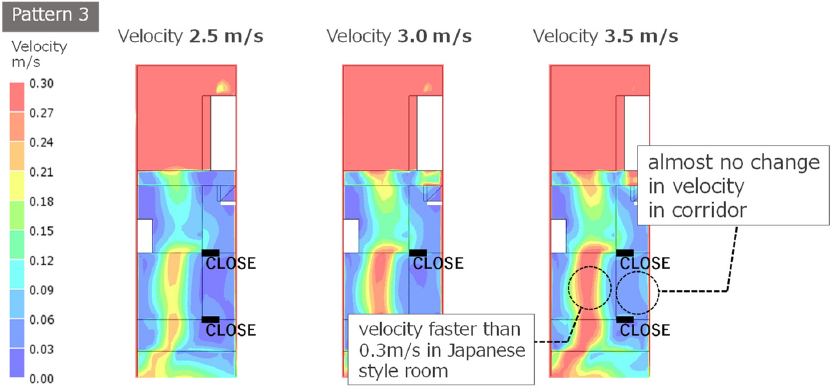
Figure 16. Simulated results of airflow velocities under different outdoor wind